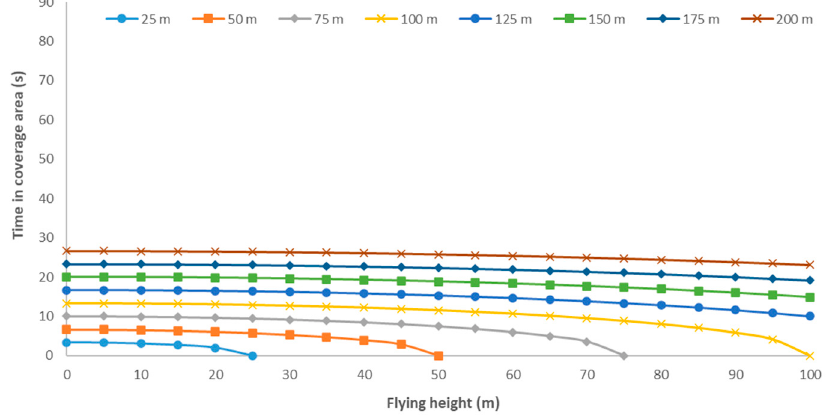
Figure 10. Time in coverage when a drone flies at 15 m/s and different dc .